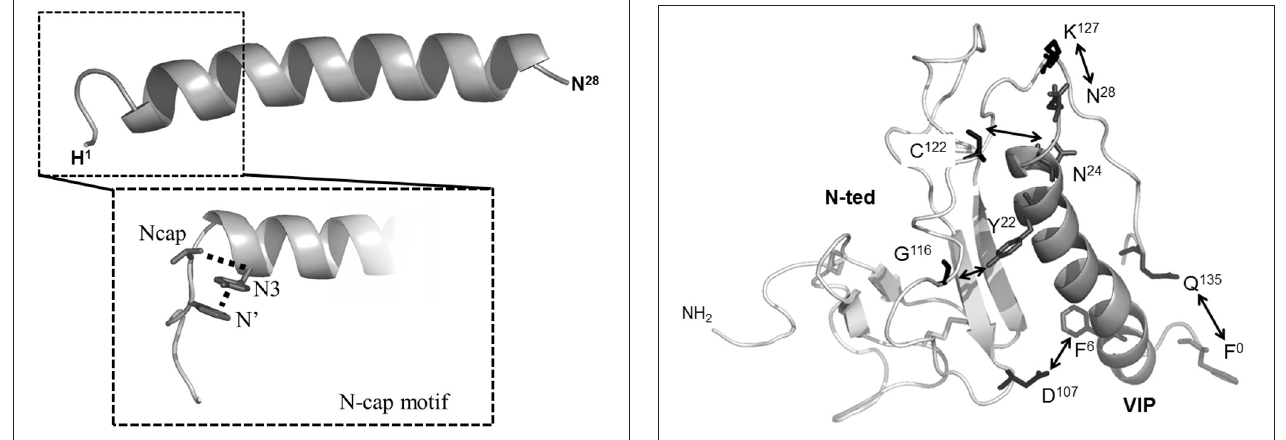
FIGURE 3 | The 3D-structural model of VPAC1 receptor N-ted and docking of VIP. Ribbon representation of the VPAC1 N-ted: light gray ribbon , main chain; white ribbon , VIP. Docking calculations showed that Q 135 , D 107 , G 116 , C 122 , and K 127 residues ( middle gray sticks ) present in the N-ted were in contact ( white arrows ) with the side chains of F 0 , F 6 , Y 22 , N 24 , and N 28 ( black sticks) of VIP residues, respectively. Figure was obtained by using PyMOL software